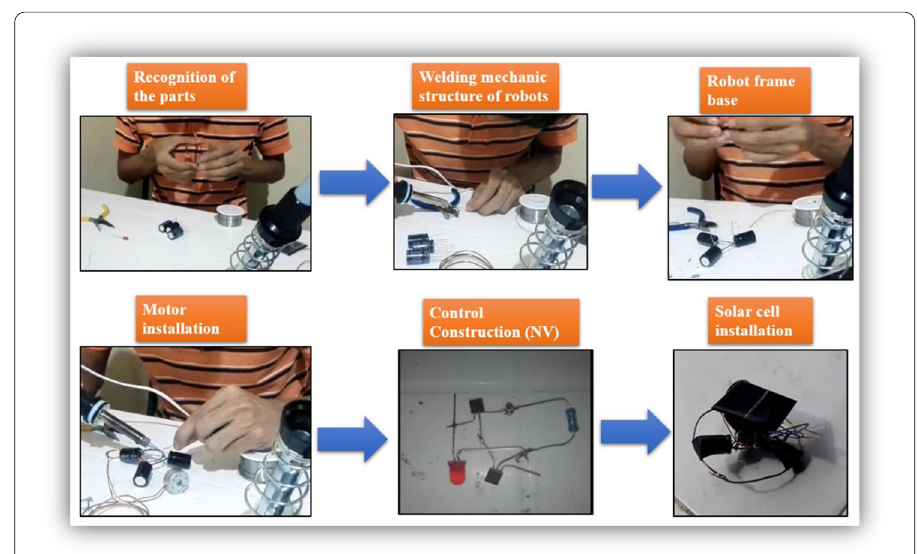
Fig. 11 SYMMET robot construction process followed by all